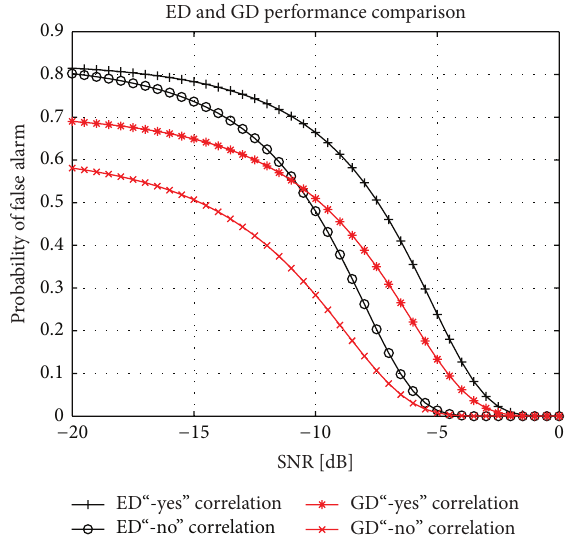
Figure 4: ROC of ED and GD.